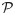
Effect of fluctuating nutrient supplies on the tissue.(a) Number of cells at the end of simulations (t = 100,000 MCS), showing for simulations with different vessel tortuosities (P) and different cell mutation rates (μ). In simulations with healthy vessels (high switching probability P) a mutating cell population produces more cells than non-mutating ones. However, in simulations with erratic nutrient supply (with lower blocking probability P), the mutating populations die out more frequently than the non-mutating ones. At extreme erratic switching (P=0.001) 10 out of 10 mutating populations are extinct and even healthy ones start to die out (2 out of 10 simulations). Error bars indicate standard deviation of cell numbers from 10 repetitions. Values belonging to different simulations with the same mutation rate are connected and are slightly shifted on the x-axis for better visibility. (b) Average intracellular growth signal evolution in the population are not changed in simulations with different vessel blocking probabilities (mutation rate μ = 0.1%). This shows that the vessel blocking probability does not directly affect selection and progression speed. (c) The average intracellular growth signal in simulations with decreasing vessel blocking probability (P=P(t), solid lines) in mutating (red, μ = 10%) and not mutating (blue, μ = 0%) populations. Cell-cell competition in mutating populations initially drives the growth parameters to a high value just as in the simulations with stable nutrient sources. When the blocking probability reaches the magnitude of P(t)=0.01 and below, populations die out (dashed lines: percentage of simulations with living cells). (d) Population sizes in simulations with stable nutrient sources (P=0.5) and in simulations where the blocking probability is controlled by the cell density (P=P(ρ)), creating a feedback. In both cases the populations survive. The tissue coverage is approximately halved, making the vessel blocking probability approximately P=0.27 in the feedback simulations.